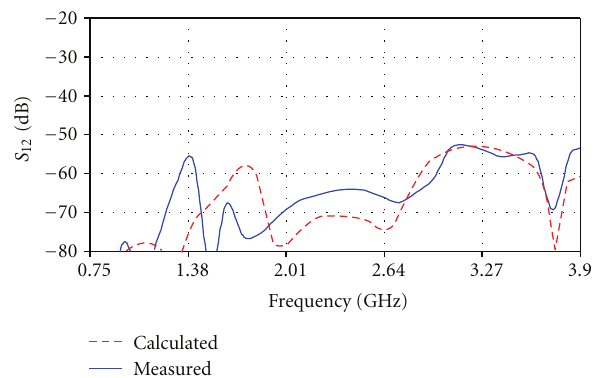
Figure 15: Mutual coupling ( S 12 ) between the antennas of the third configuration on a laptop